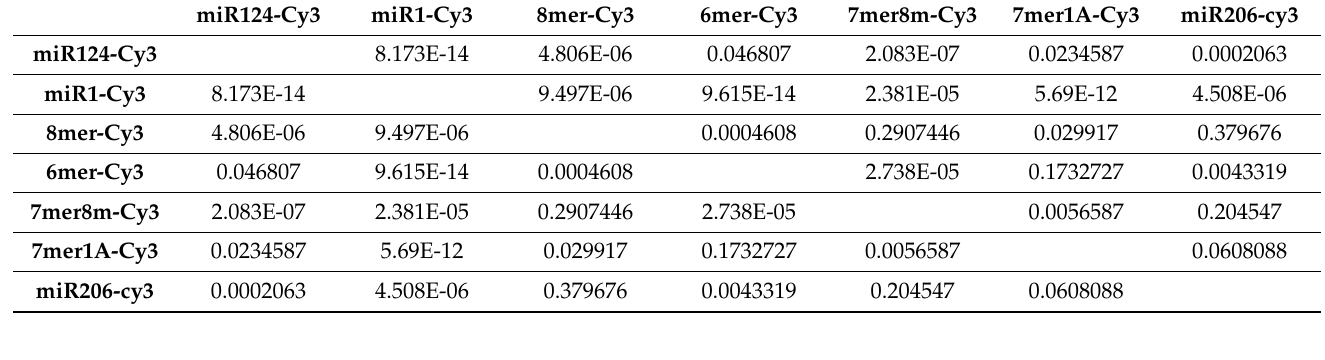
Table 6. Descriptive statistics for Figure 2C—modifications in synthetic miRNA-1.